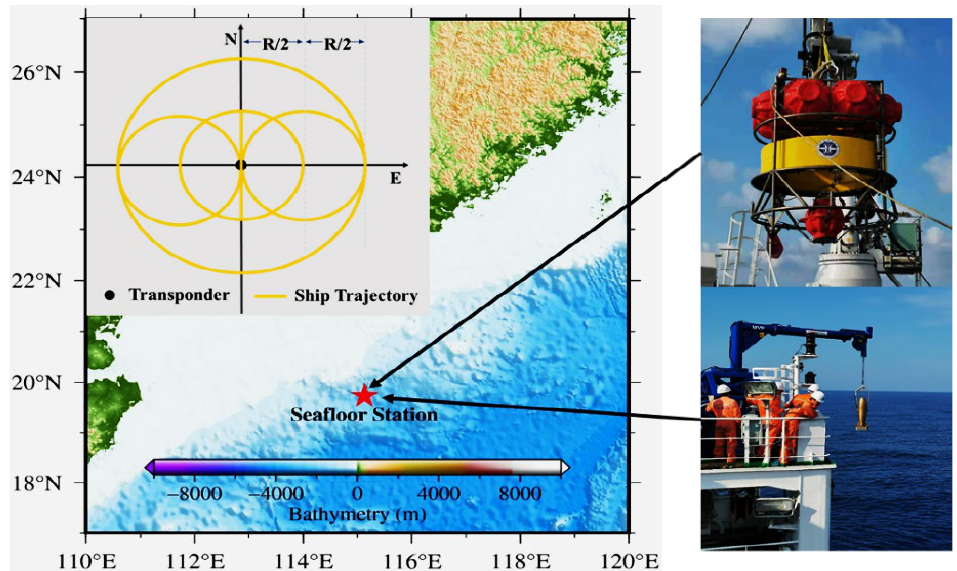
Figure 6. The ship trajectory scheme as it collected GNSS/acoustic data with a lander and mobile velocity profile.